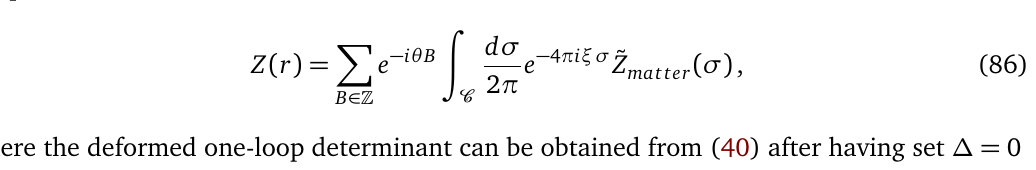
Figure 5: Difference d ( 1 ) , as ( 0 ) . The blue line is given by the equation y = − C ( 0 ) c 0, n